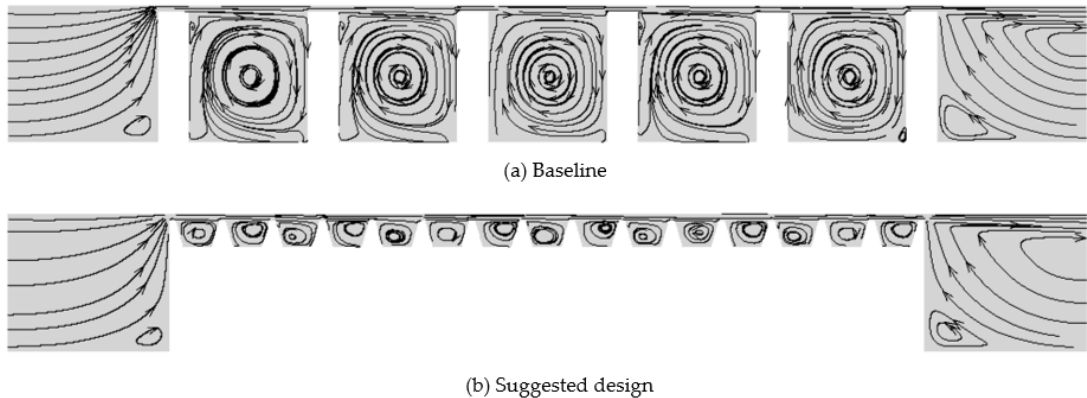
Figure 19. Streamlines of the labyrinth seal under a pressure ratio of 2 for ( a ) baseline and the ( b ) suggested design. Table 6. Jet divergence angle and discharge coefficients for the baseline and suggested optimal geometry for a labyrinth seal under pressure ratios of 1.1, 1.5, and 2.